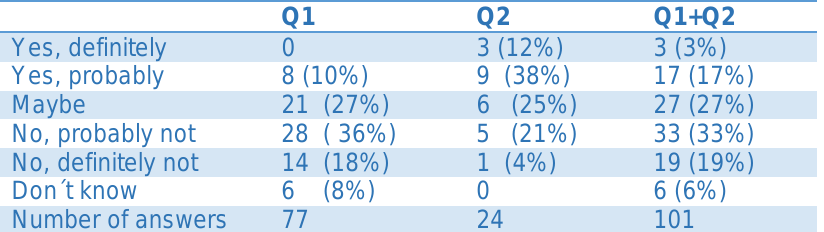
Table 3: Statement. Cost overruns would be considerably less if Design Build would be used instead of Design Bid